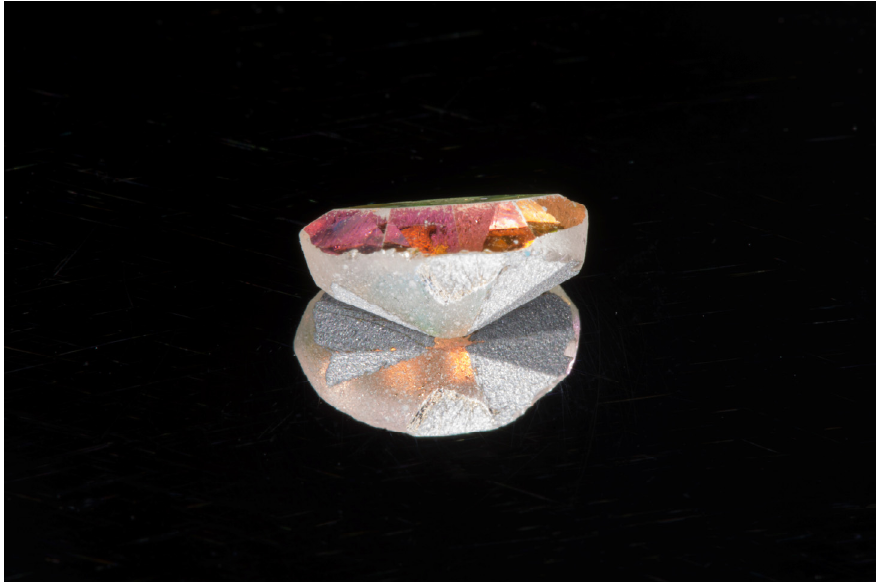
Figure 4. The foreign body removed from the external auditory canal.